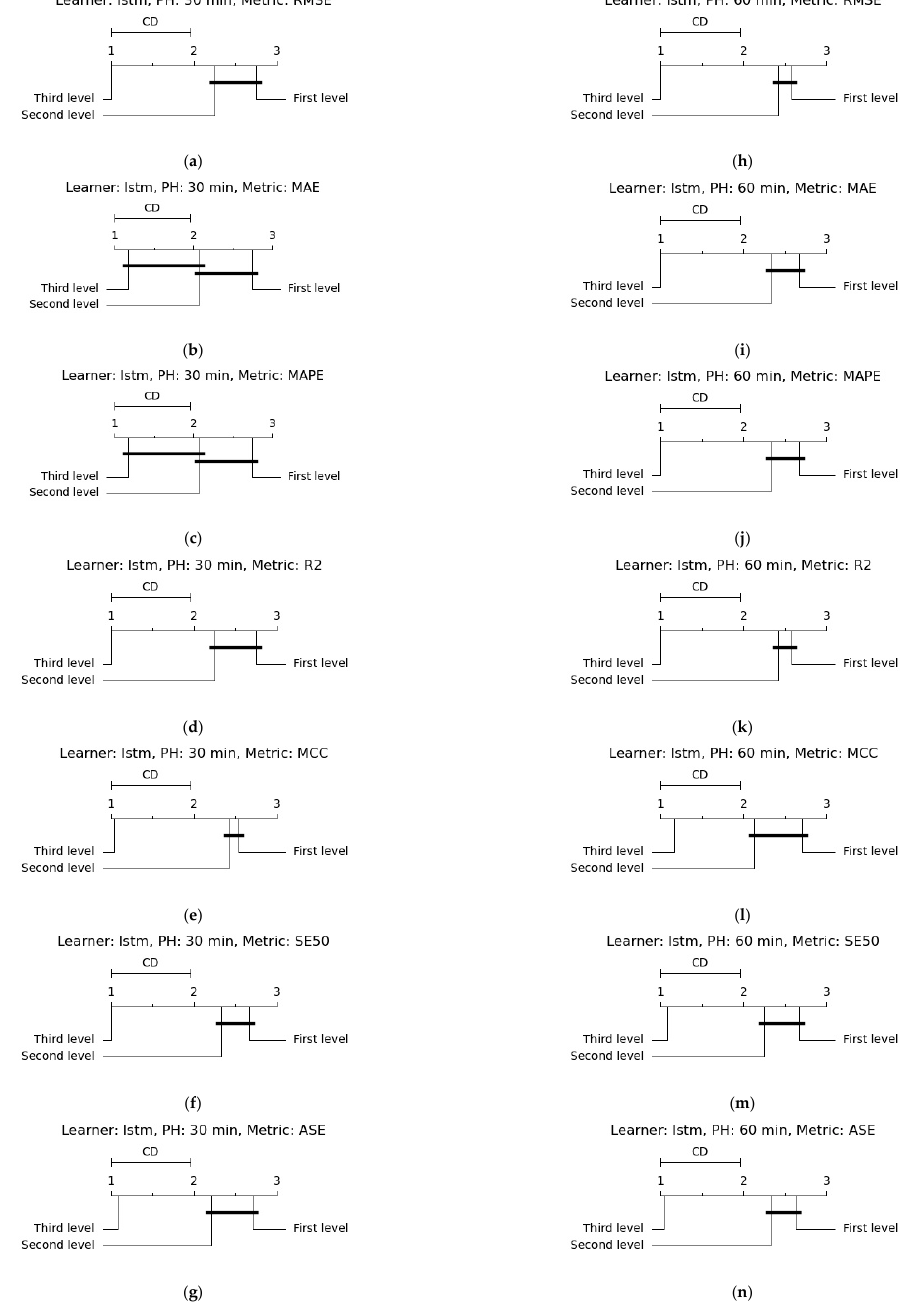
Figure 2. Critical difference diagrams based on Nemenyi test for pairwise comparison of the non- stacking, stacking, and nested stacking modelling approaches: ( a ) LSTM learner, 30 min PH, and RMSE metric, ( b ) LSTM learner, 30 min PH, and MAE metric, ( c ) LSTM learner, 30 min PH, and MAPE metric, ( d ) LSTM learner, 30 min PH, and r 2 metric, ( e ) LSTM learner, 30 min PH, and MCC metric, ( f ) LSTM learner, 30 min PH, and SE50 metric, ( g ) LSTM learner, 30 min PH, and ASE metric, ( h ) LSTM learner, 60 min PH, and RMSE metric, ( i ) LSTM learner, 60 min PH, and MAE metric, ( j ) LSTM learner, 60 min PH, and MAPE metric, ( k ) LSTM learner, 60 min PH, and r 2 metric, ( l ) LSTM learner, 60 min PH, and MCC metric, ( m ) LSTM learner, 60 min PH, and SE50 metric, ( n ) LSTM learner, 60 min PH, and ASE metric. Note. LSTM: long short-term memory; PH: prediction horizon; RMSE: root mean square error; MAE: mean absolute error; MAPE: mean absolute percentage error; r 2 : coefficient of determination; MCC: Matthew’s correlation coefficient; SE: surveillance error; ASE: average surveillance